Question: In one sentence, what is this figure communicating?
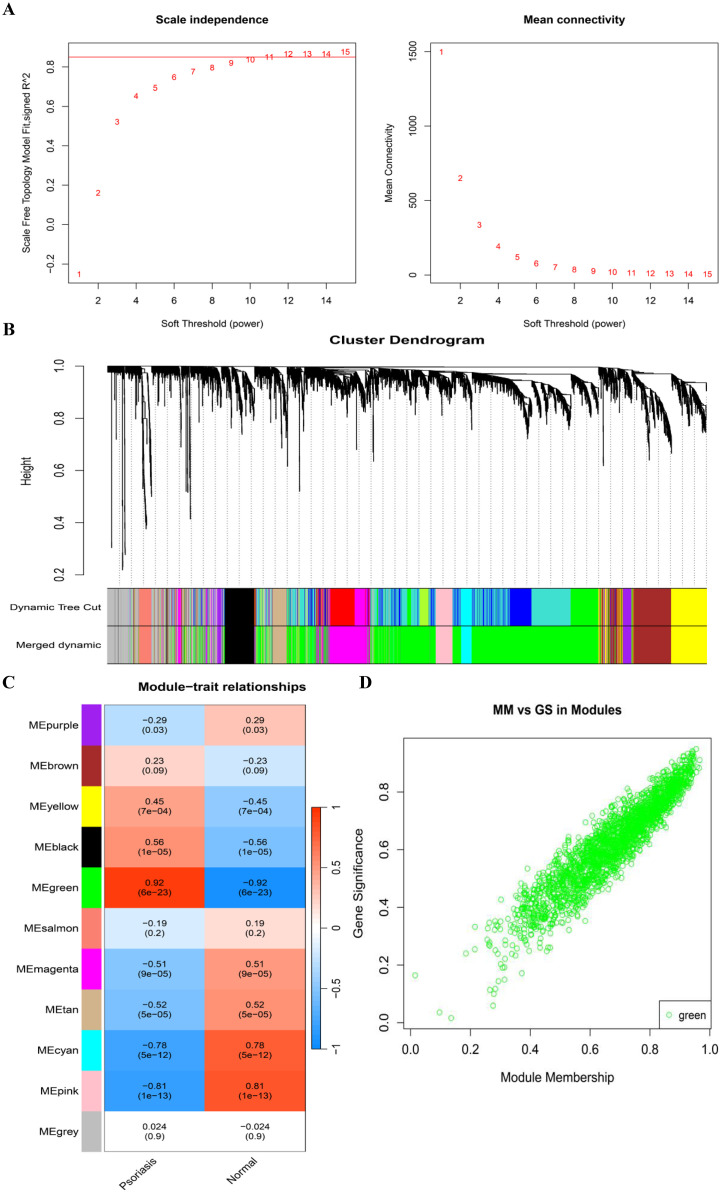
Answer: WGCNA identifies a psoriasis-associated co-expression module. (A) Scale-free topology analysis for soft-threshold selection. (B) Hierarchical clustering dendrogram with module assignment. (C) Heatmap of module–trait relationships. (D) Scatter plot showing the relationship between module membership and gene significance in the disease-associated module.